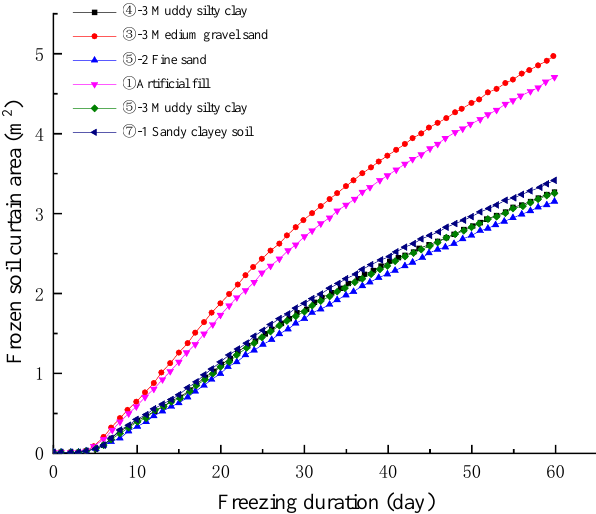
Figure 11. The area of frozen soil curtain. Table 9. The freezing duration required for the frozen soil thickness midline in different soil layers (day).